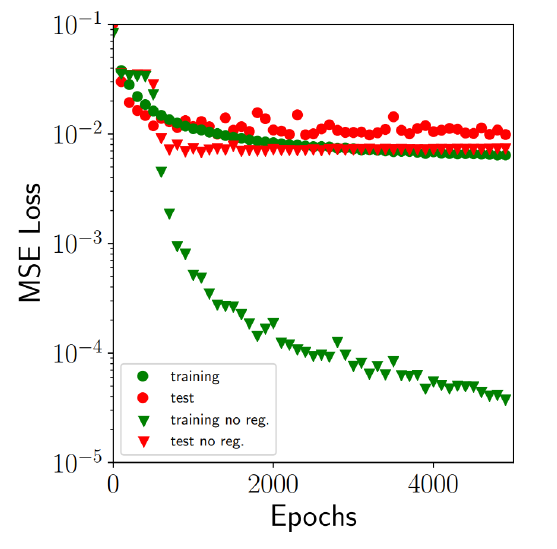
Figure 7. Training and test MSE (mean square error) losses evolution against the number of epochs training cycles. The data include losses obtained with and without the application of techniques to alleviate overfitting (data augmentation, L 2 regularization and